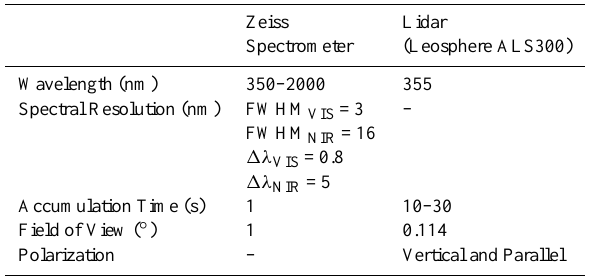
Fig. 3. Phase index dependence on LWC and IWC, respectively, for fixed viewing geometry ( θ s =50 ◦ , ϕ s =0 ◦